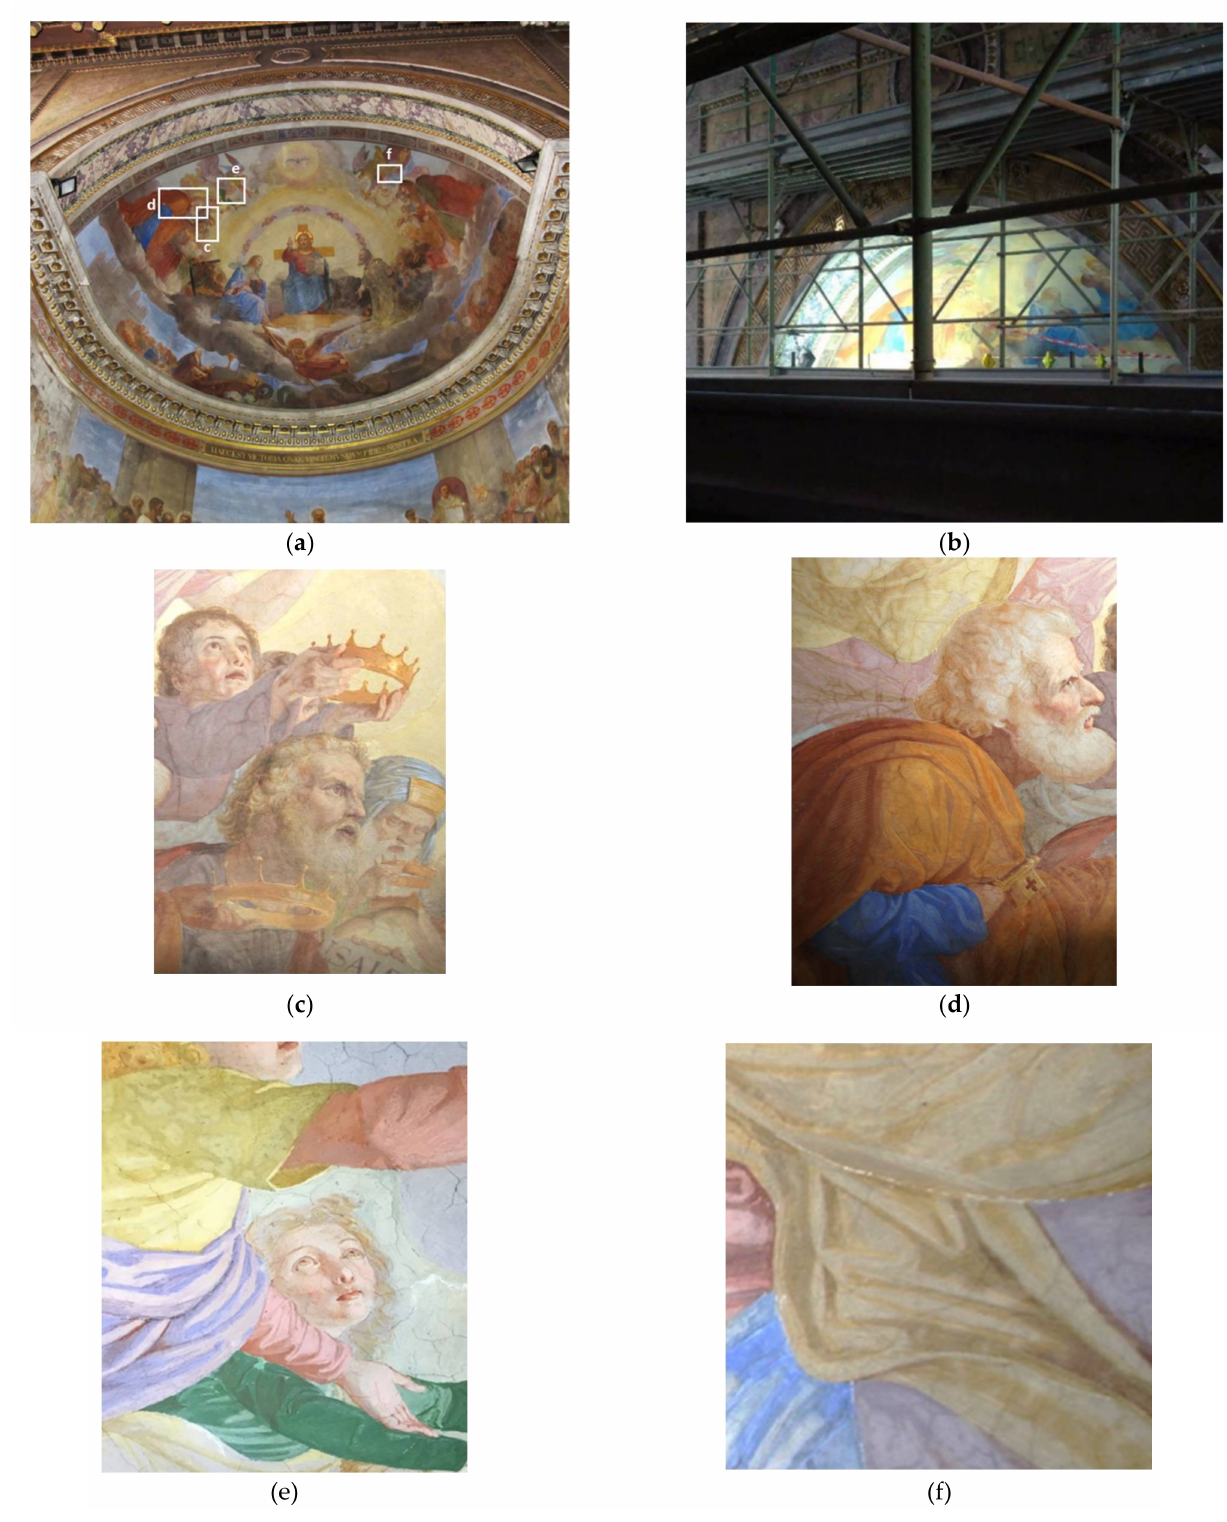
Figure 1. ( a ) Vincenzo Pasqualoni’s wall painting (Basilica of S. Nicola in Carcere in Rome). ( b ) Photo during the restoration. ( c – f ) Detail of the four areas analyzed through multispectral